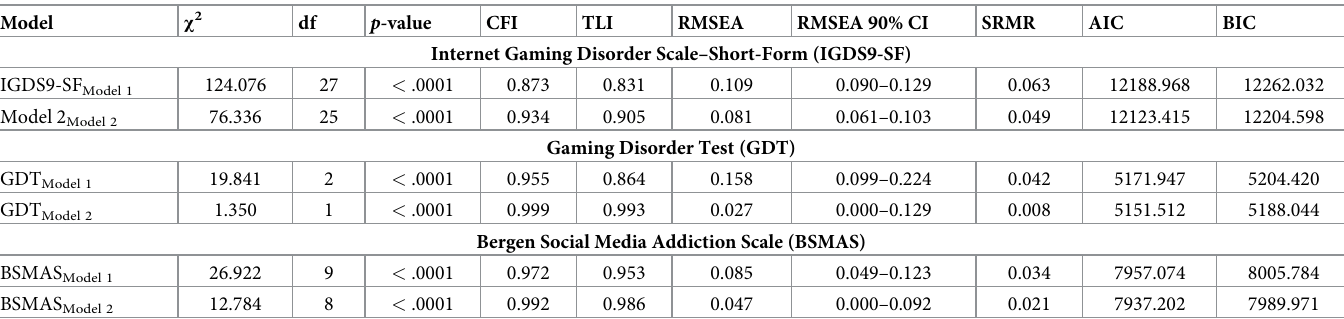
Table 6. Summary of measurement model fit indices across all three scales ( N = 428). Model χ 2